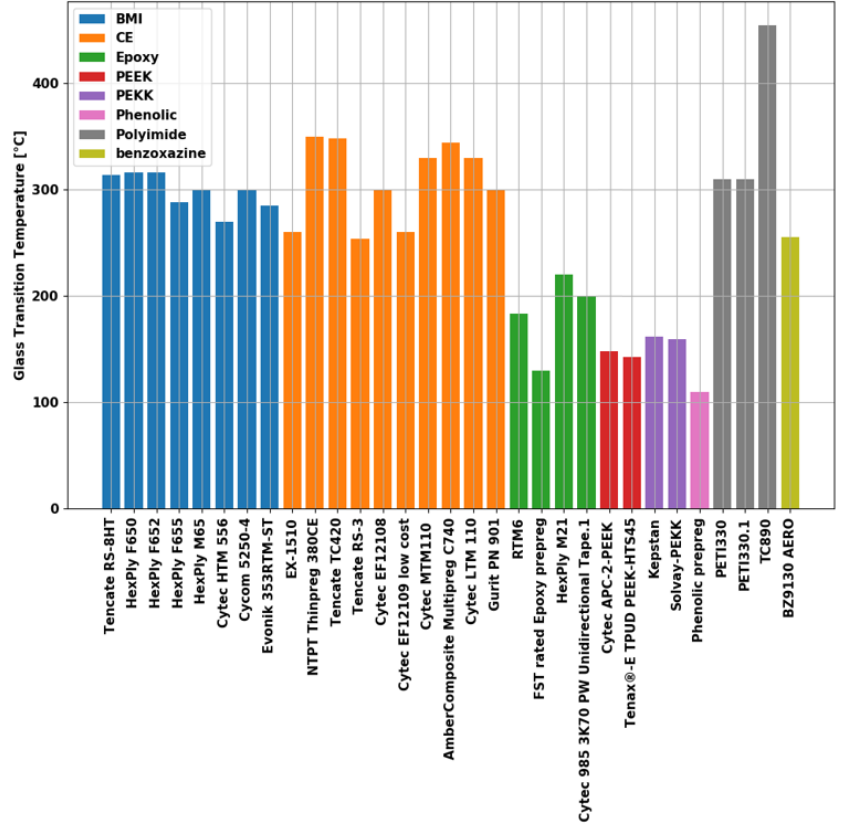
Figure 1. Overview to the glass transition temperature of commercially available high-temperature resin systems based on their data sheet values. Result from material screening in [1].